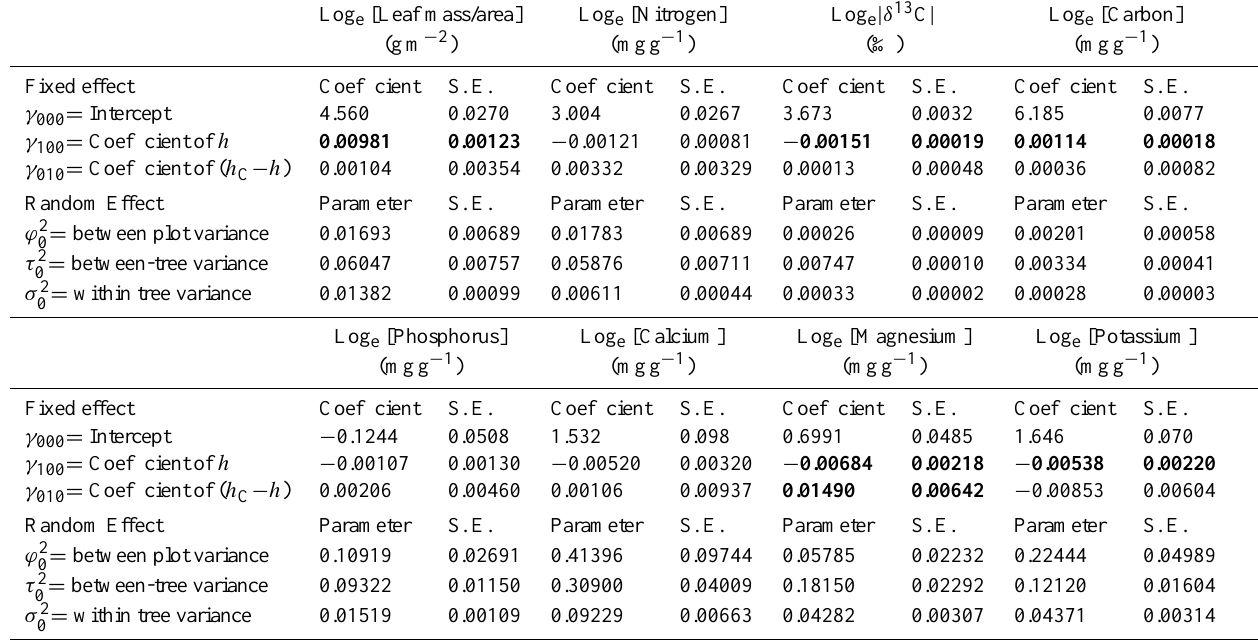
Table 1. Estimated intercept and coefficients according to Eq. (14) for leaf mass per unit area, leaf [N], leaf [C], leaf δ 13 C, leaf [P], leaf [Ca], leaf [Mg] and leaf [K] all expressed on a leaf dry weight basis. Significant values (P ≤ 0.05) are shown in